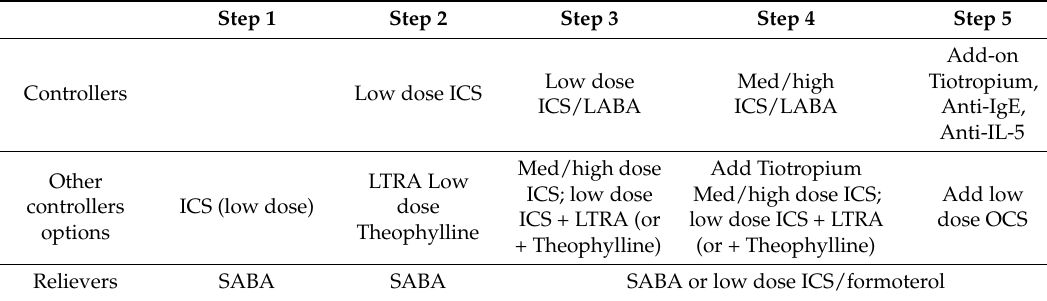
Table 1. Standard treatment steps for adult asthma.